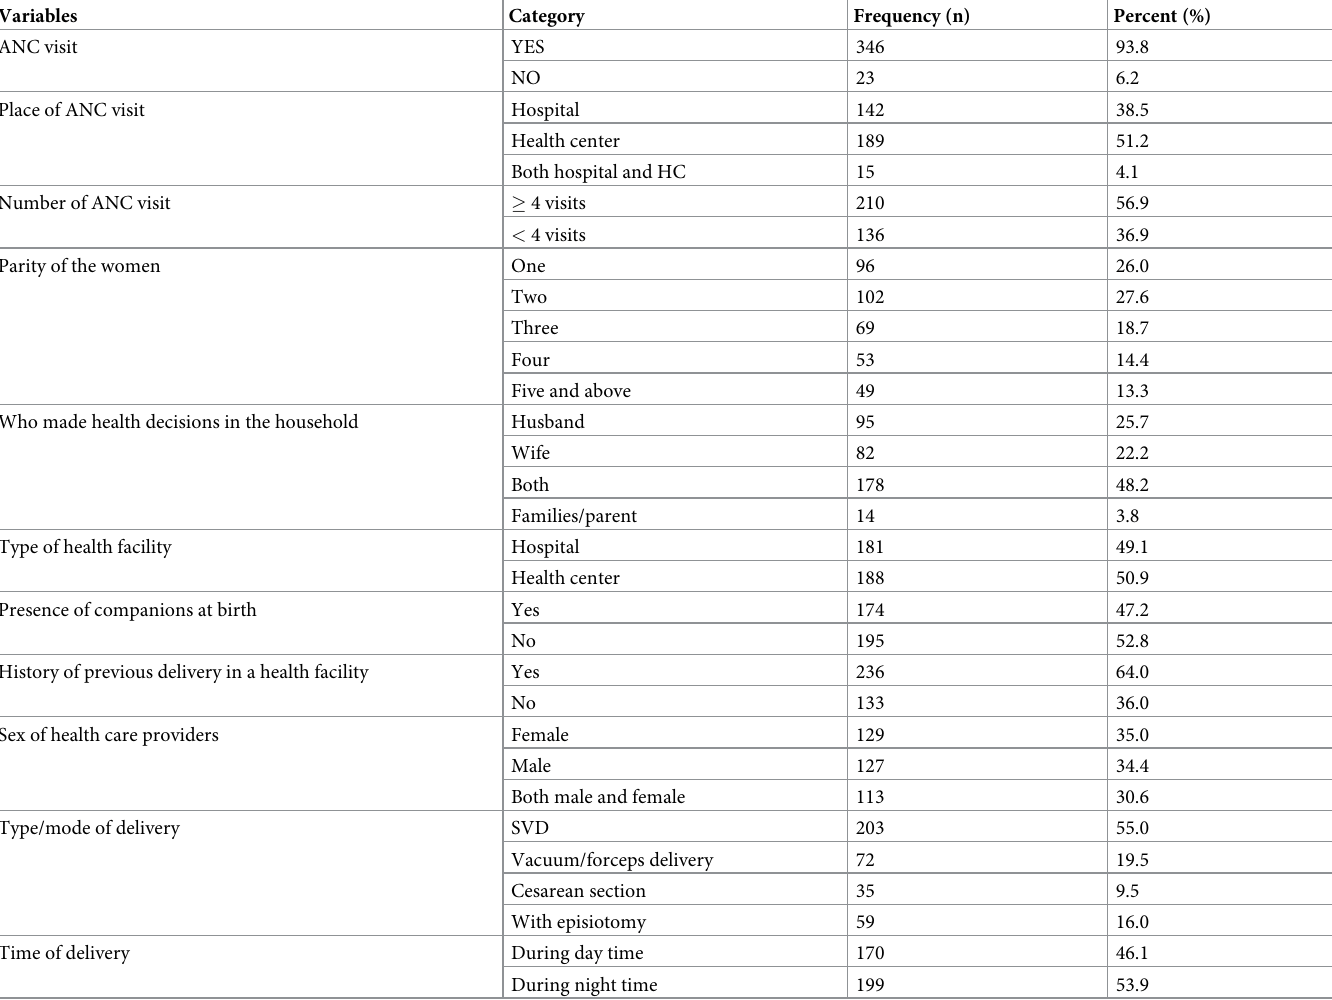
Table 2. Obstetric history of women in Borena District, Amhara Region, Ethiopia, 2020 (n = 369).